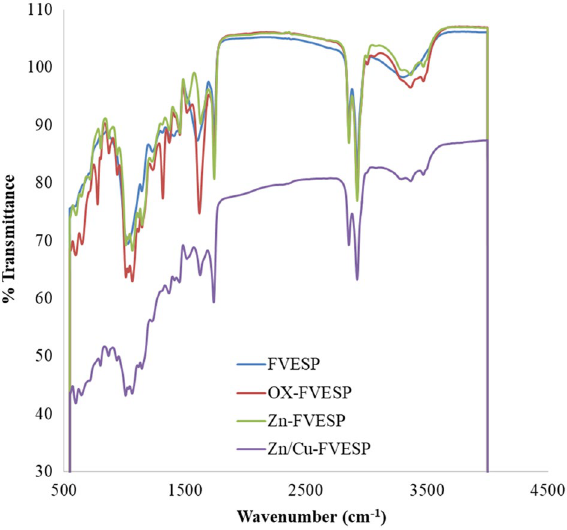
Figure 1. FT-IR for the FVESP and Ox-FVESP and Zn-FVESP and